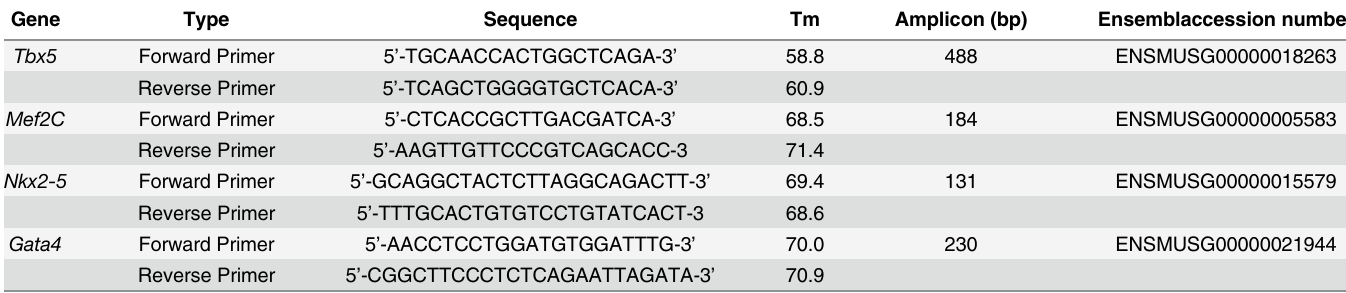
Table 1. Primer sequences for biomarker genes of cardiac